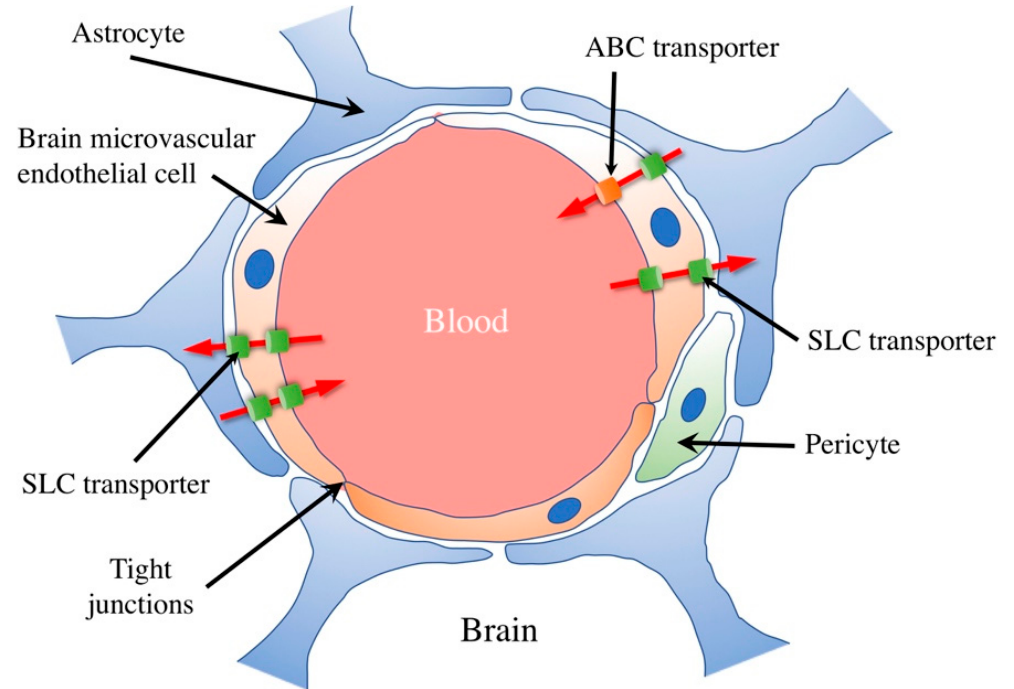
Figure 1. Schematic illustration of the blood–brain barrier and transporters. The blood–brain barrier is composed of brain microvascular endothelial cells, astrocytes, and pericytes. Diffusion between cells is limited by the mutual binding of brain microvascular endothelial cells by tight junctions. Many of the soluble carrier (SLC) transporters expressed in brain microvascular endothelial cells allow substances, such as nutrients (e.g., glucose, amino acids, peptides, and nucleotides), to selectively cross the blood–brain barrier. In addition, ATP binding cassette (ABC) transporters that are expressed in cerebral microvascular endothelial cells play a role in preventing the entry of toxic substances and drugs into the brain by releasing them into the blood.